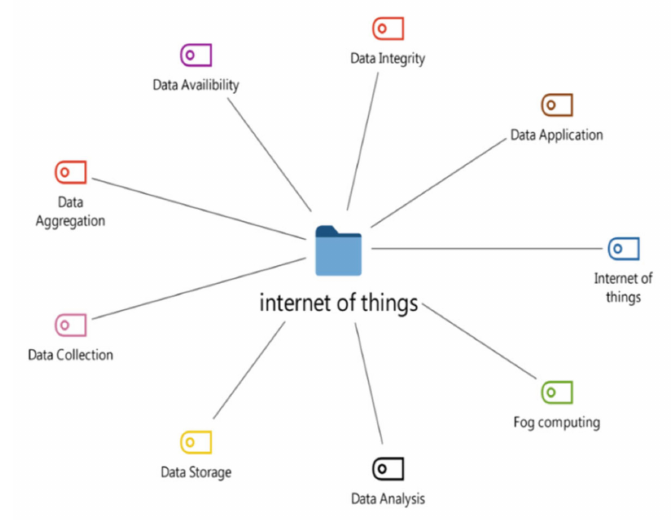
Figure 16. Security Model for the